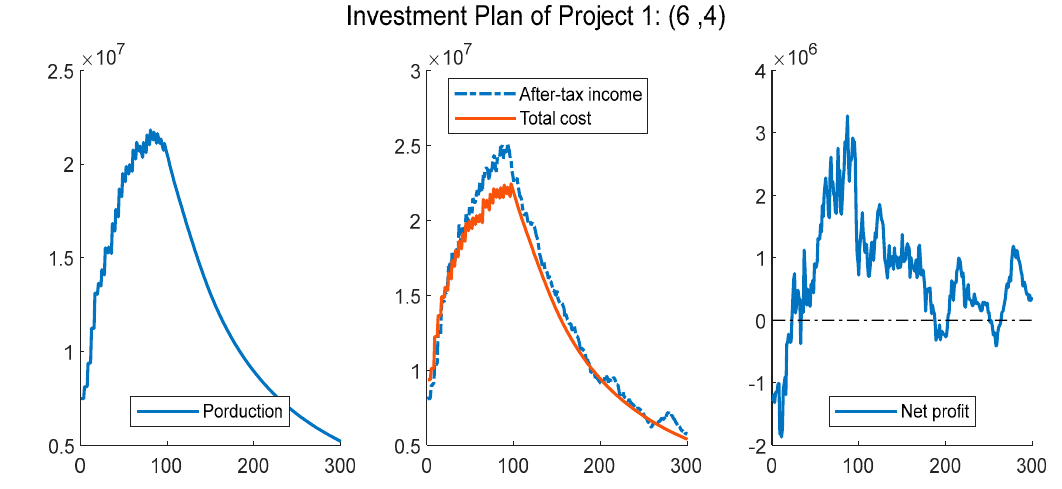
Figure 12. Production, income, cost and, net profit of project 1.